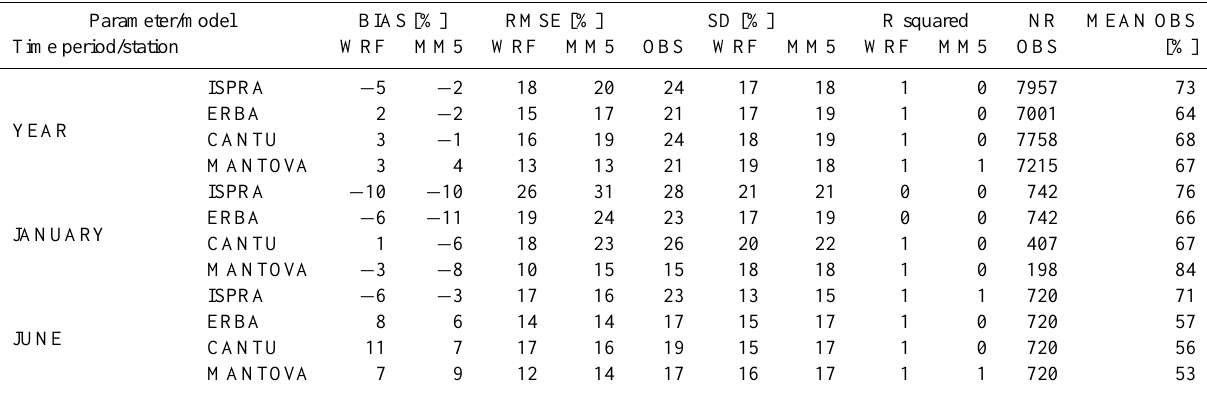
Table 3b. Statistics for the relative humidity at the 2m